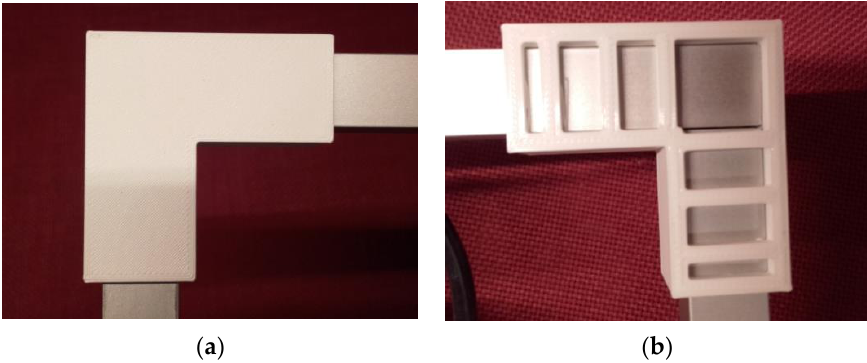
Figure 12. Printed square elbow for the camera holder tubes: ( a ) Front view; ( b ) Rear view.